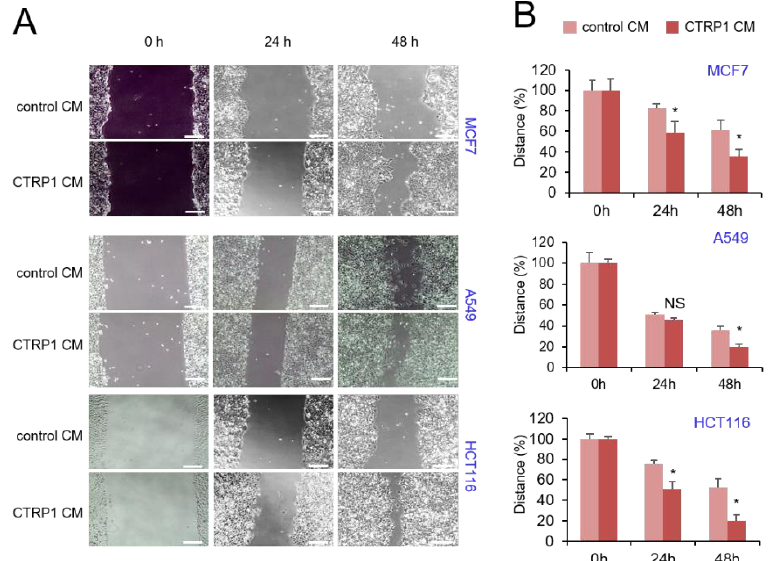
Figure 6. CTRP1 CM increases cell migration of cancer cells. ( A ) Cell migration of HCT116 cells, MCF7 cells, and A549 cells were measured with control CM or CTRP1 CM. Equal numbers of cells were plated in each well of a 6-well plate, and cells were scraped with a pipette tip. After the indicated times, images of the wound gaps were captured with a microscope. ( B ) The distance of the wound was analyzed by the Image J software. * p < 0.05.